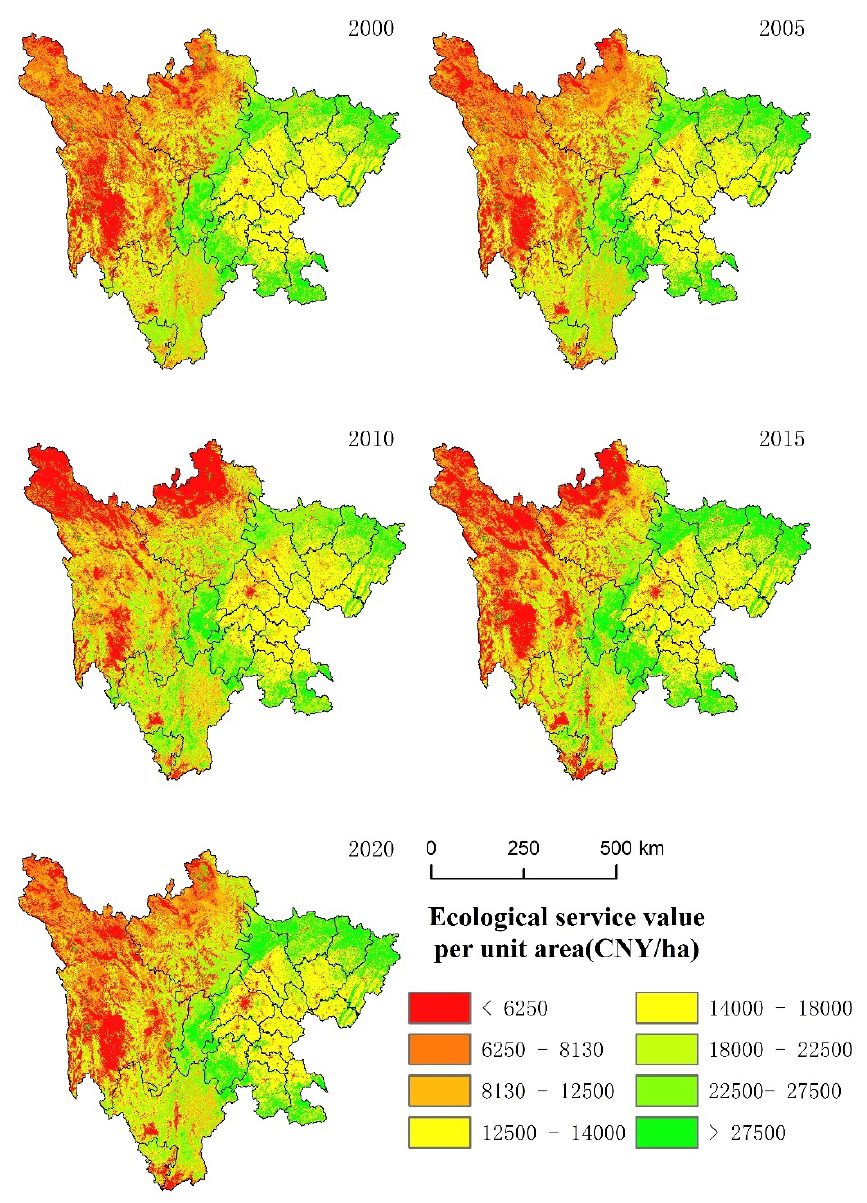
Figure 4. Spatial distribution of ESVs in Sichuan Province from 2000 to 2020.